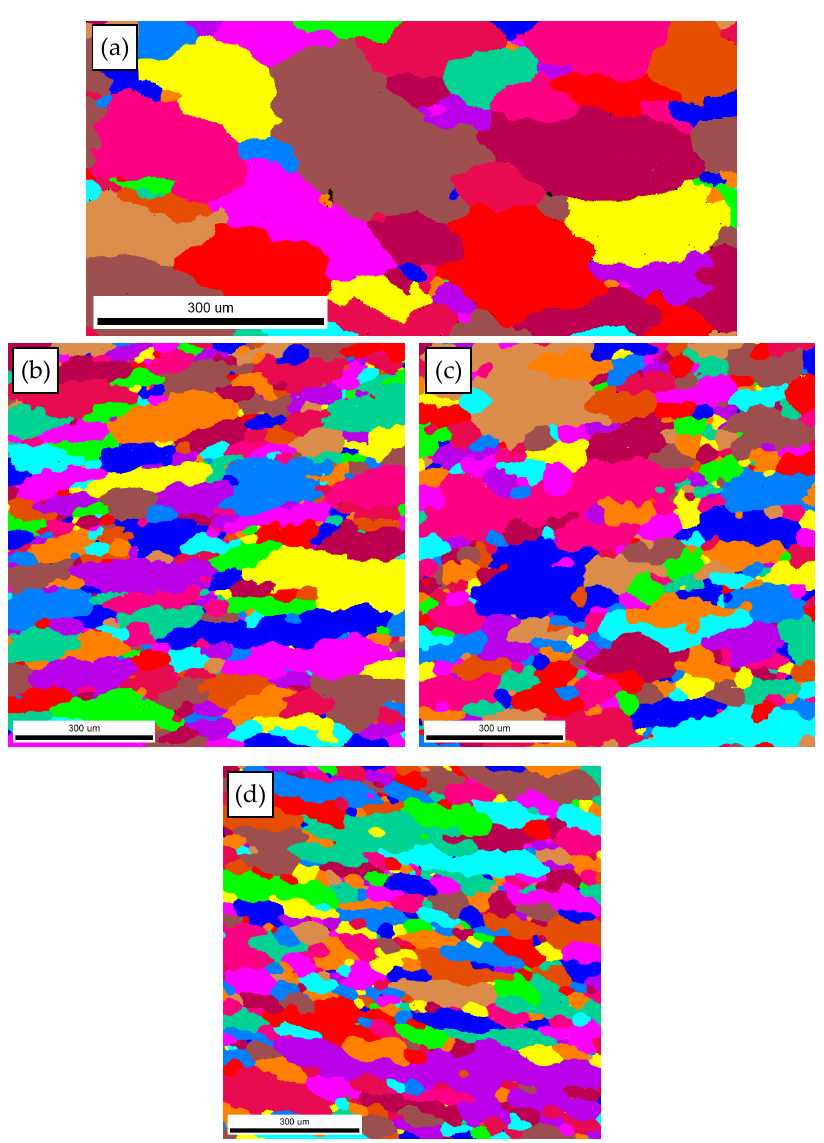
Figure 6. EBSD grain maps of the TB8 titanium alloy deformed at different strains of ( a ) 0.2, ( b ) 0.4, ( c ) 0.6 and ( d ) 0.8.